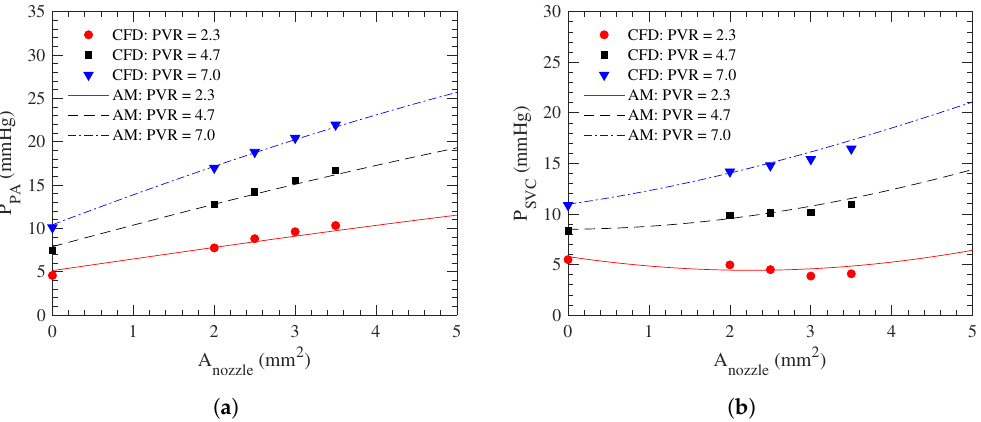
Figure 7. ( a ) the mean pulmonary artery pressure, P PA and ( b ) the mean SVC pressure, P SVC , as a function of the nozzle area, A nozzle , at different PVR values. Lines correspond to the algebraic model (AM) and symbols to the CFD.